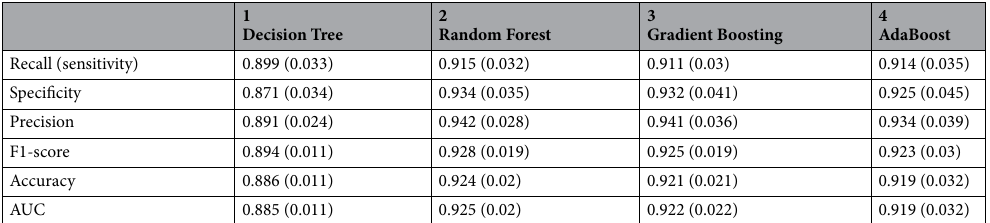
Table 3. Classification models performance metrics, after excluding 6 variables. This table shows the predictive performance across classification models (1) Decision tree, (2) Random Forest, (3) Gradient Boosting, (4) AdaBoost. For each metric, we present the mean value and standard deviation based on ten-fold cross-validation.